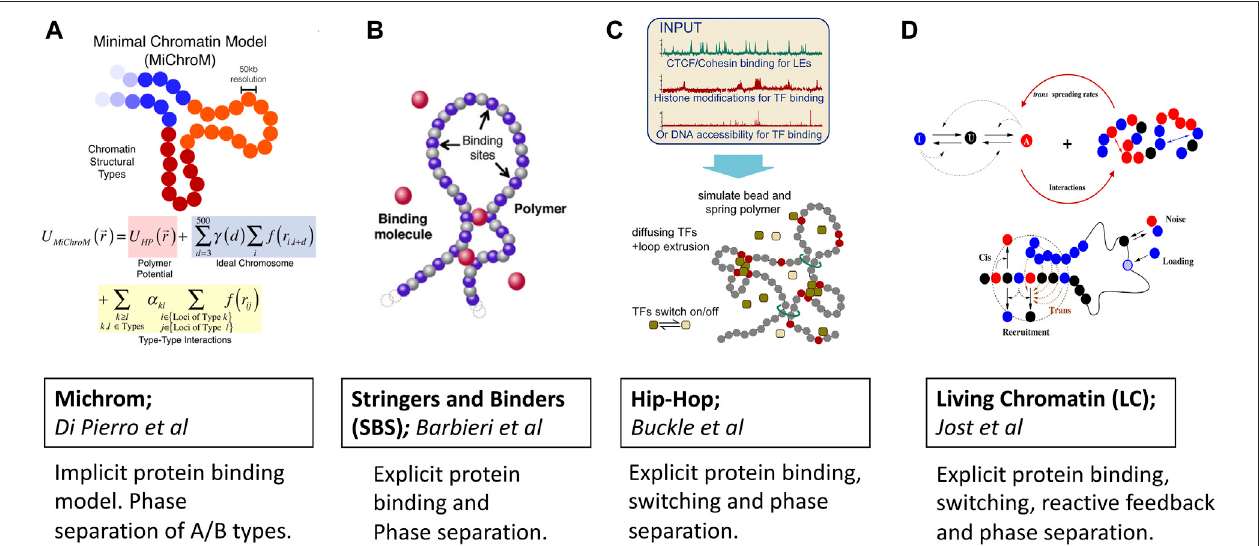
FIGURE 2 | Predictive polymer models of 3D chromatin folding based on protein binding, loop extrusion and phase separation ideas. Images are adopted from original papers with copyright agreement. From left to right; (A) Michrom Di Pierro et al. (2018), (B) Stringers and Binders Barbieri et al. (2012), (C) Hip-Hop Buckle et al. (2018) and (D) Living Chromatin Jost and Vaillant